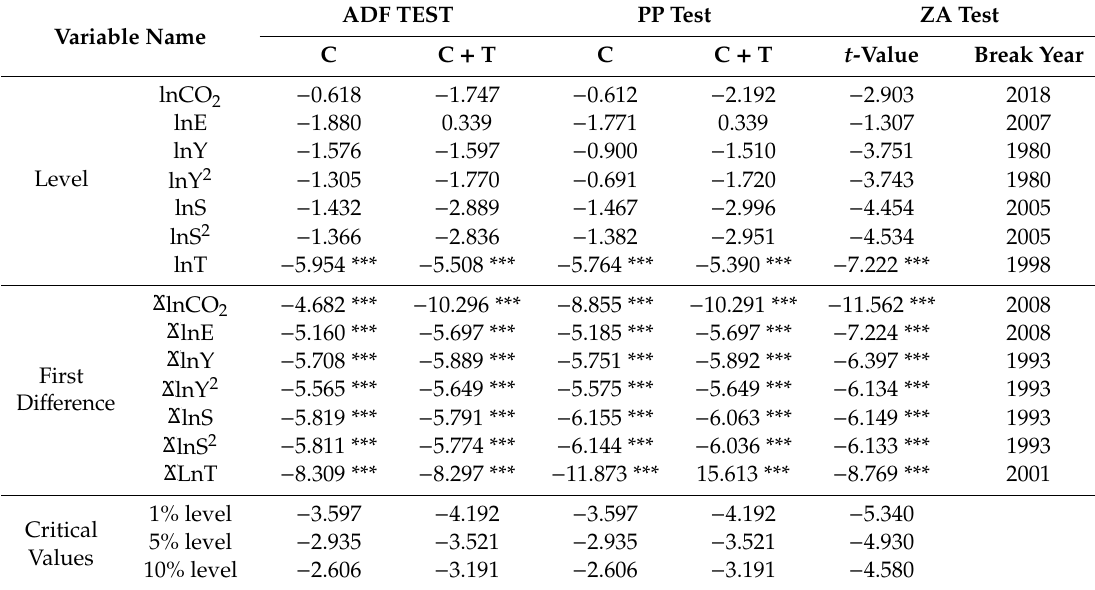
Table 3. Checking data stationarity using unit root tests.